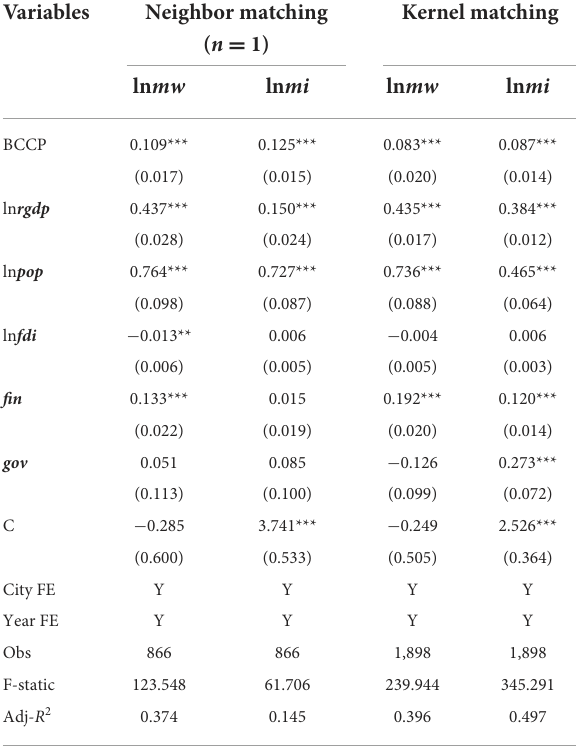
TABLE 8 Re-estimation using